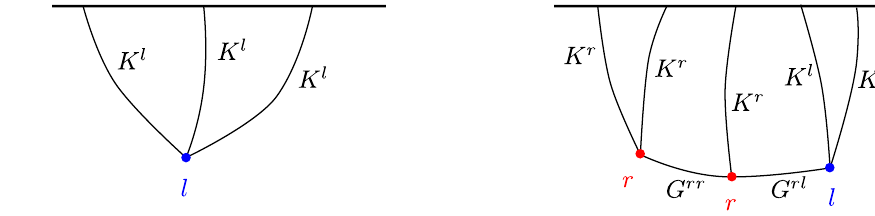
Figure 3 . Examples of dS Feynman diagrams for the φ 3 theory. Vertices are labeled by r/l to denote if they are coming from the expansion of the time-ordered “right” time-evolution operator, or the anti time-ordered “left” one, in eq. (3.2). The propagators connecting the vertices to the insertions at the future boundary, or extending between two vertices, depend on the r/l labels through the different i(cid:15)